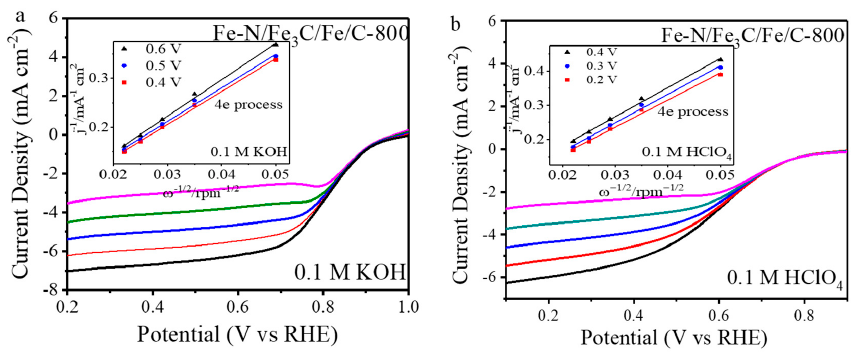
Figure 5. ( a ) ORR polarization curves of Fe-N/Fe 3 C/Fe/C-800 at different rotating rates and K–L plots (inset) in 0.1 M KOH; ( b ) ORR polarization curves of Fe-N/Fe 3 C/Fe/C-800 at different rotating rates and K–L plots (inset) in 0.1 M HClO 4 .